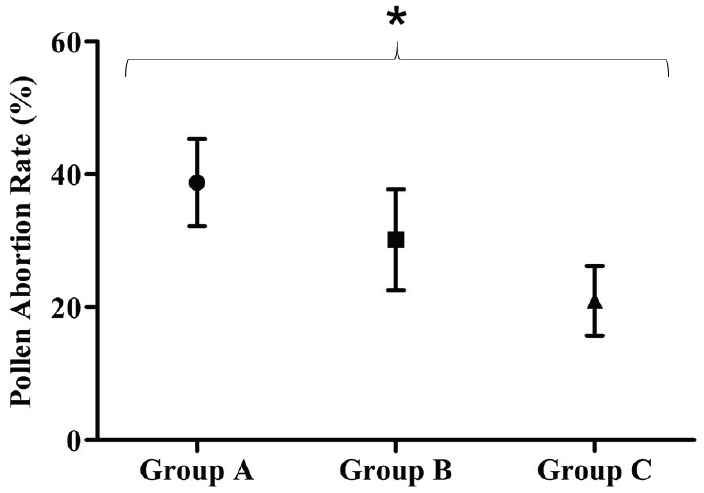
Figure 4. Pollen abortion rate in monitoring